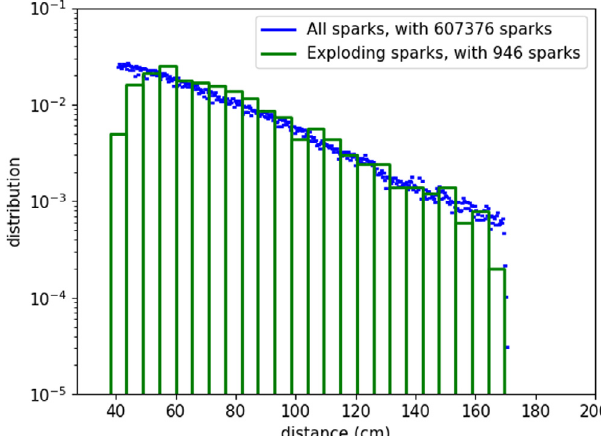
Fig. 7. Distance distribution of the sparks (blue) and explosions (green) for the hypoeutectoid steel with 100 N applied. We represented only the top of the bars for the distribution of the sparks for readability